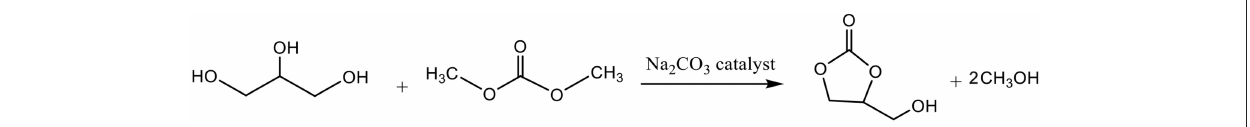
FIGURE 7 | Transcarbonatation of glycerol with dimethyl